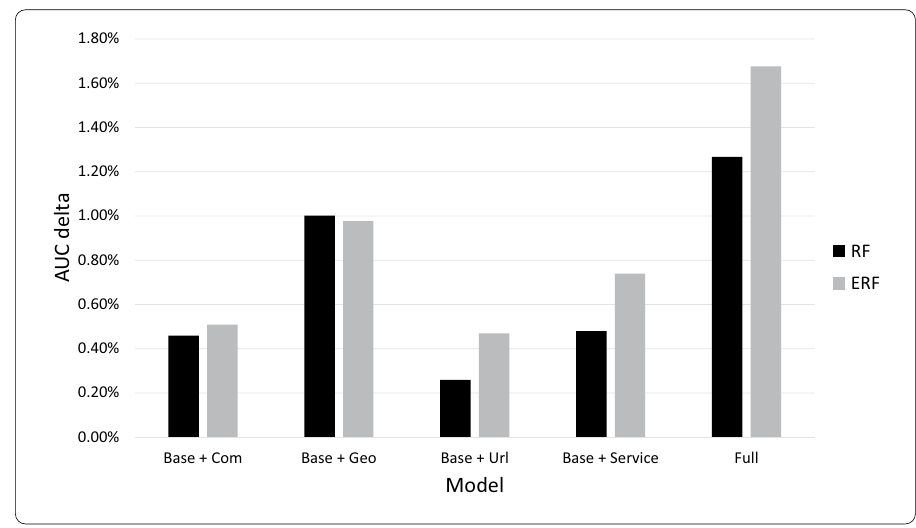
Fig. 2 Incremental AUC value by fine-grained data source: RF VS ERF (500